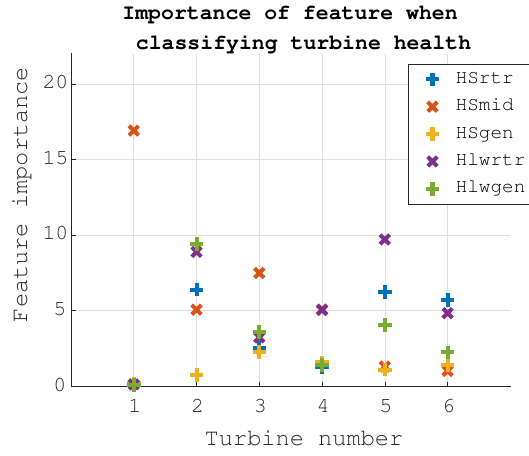
Figure 10. Dataset 2 PFI results.